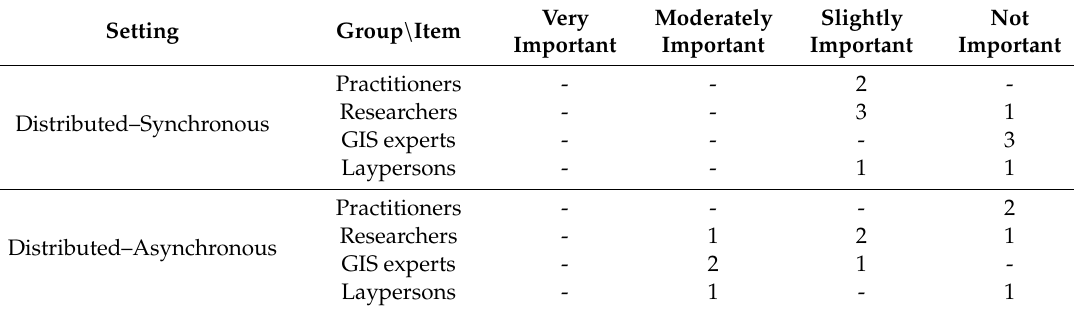
Table 3. Need for supporting di ff erent space-time